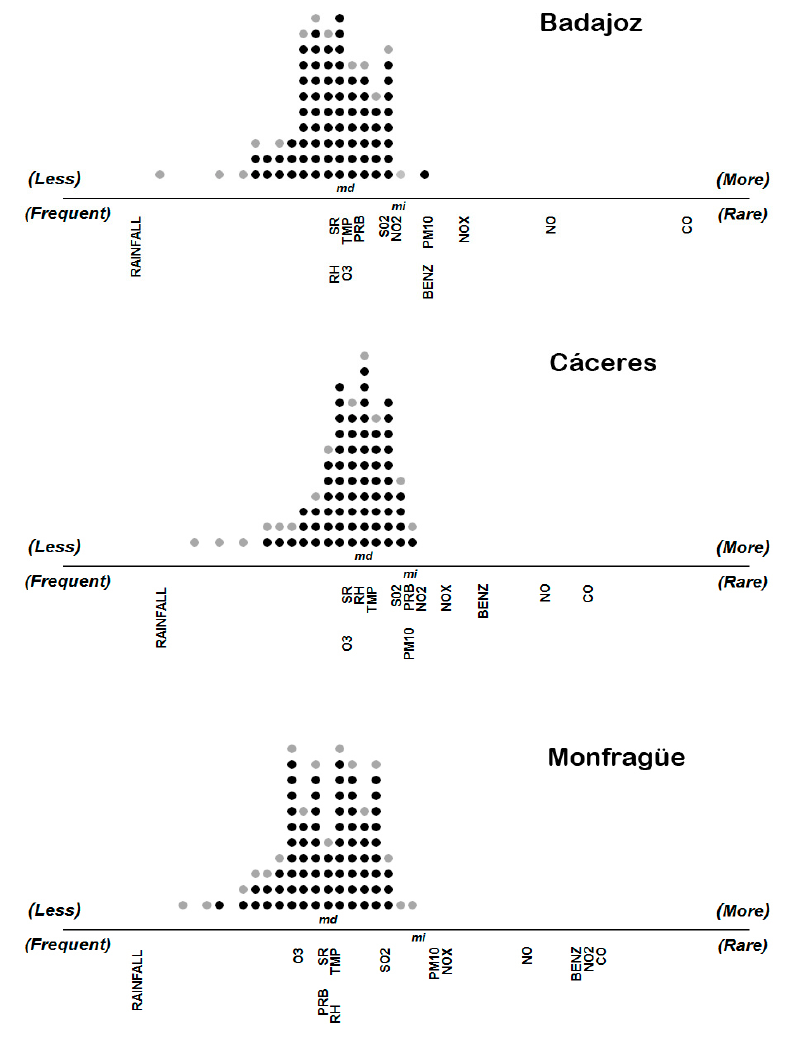
Figure 3. Variable maps for the three locations. The straight line represents the latent variable: atmospheric pollution. Days in 2016 (each black point is 4 days and each grey point is 1 to 3 days) are represented above the line according to their atmospheric pollution measure: to the right those when higher atmospheric pollution level occurred; to the left those when lower atmospheric pollution level occurred. Individual pollutants and climatic factors are below the line: to the right those with lower influence on atmospheric pollution (rare); to the left those with higher influence on atmospheric pollution (frequent). Rainfall represents the lack of precipitation, RH is the relative humidity, SR is the solar radiation, TMP is the mean air temperature, PRB is the barometric pressure, and BENZ is benzene. The item that obtained the highest measure in all three studied locations, and is to the right in the continuum (Figure 3), is the CO (their measures were 3.88, 2.57, and 2.65, in Badajoz, Cáceres and Monfragüe, respectively; see Table 4). This means it is the less common item, i.e., its influence on atmospheric pollution is the lowest. The same is apparent in Table 4 because its raw score is consequently the lowest. At the other extreme, the lack of precipitation (it is represented as rainfall in Figure 3, Tables 4 and 5) is situated (their measures were − 3.88, − 3.27, and − 3.72, in Badajoz, Cáceres and Monfragüe, respectively; see Table 4), with the highest score, being the more common item